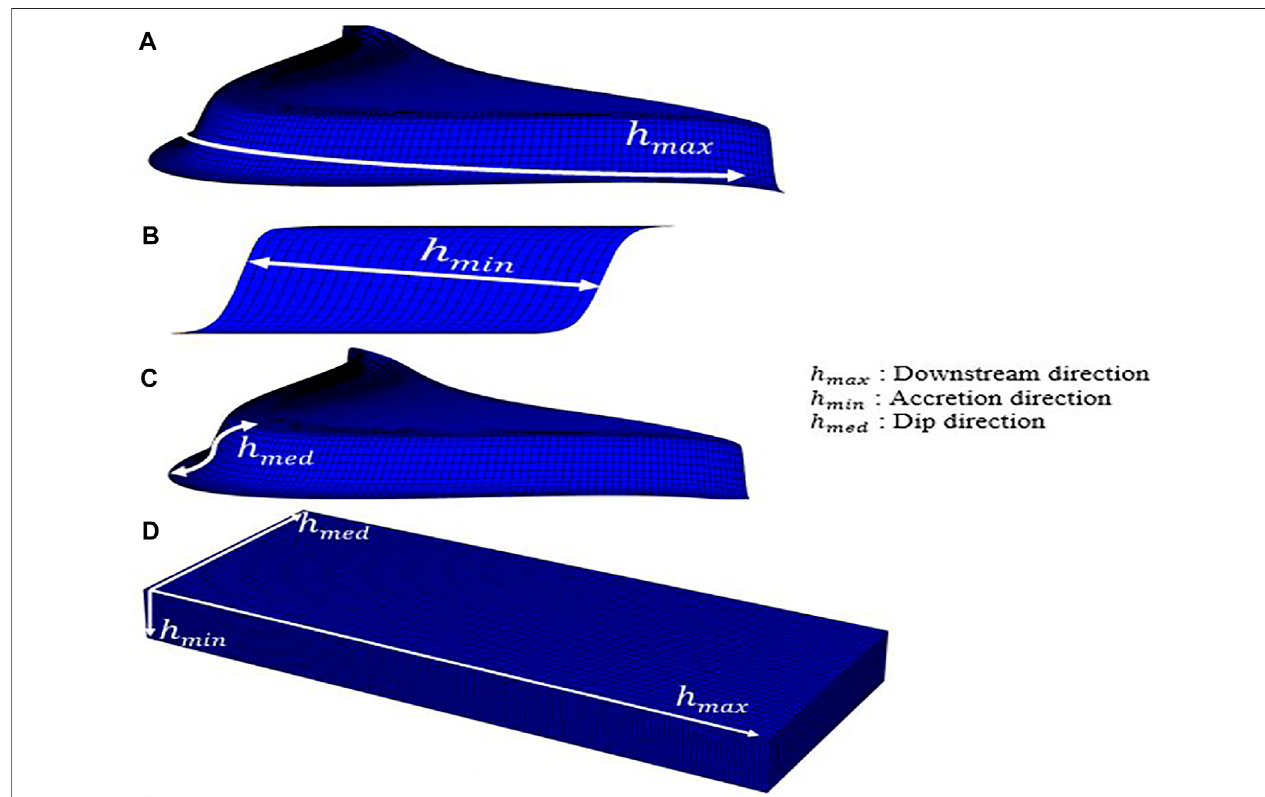
FIGURE7 | Variogram directions in (A,B,C) curvilinear grid and (D) rectilinear grid. h max , h med and h min are inthe downstreamdirection, dip directionand accretion direction, respectively. Please note: the lengths of arrows indicated here are not depicting the magnitude of the ranges; they are just guiding the reader in identifying the directions of spatial continuities.